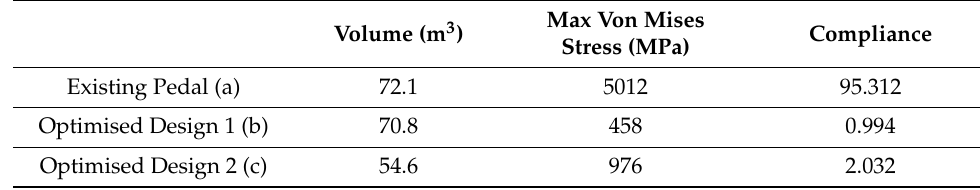
Figure 3. ( a ) Existing pedal ( b ) Optimised design 1 ( c ) Optimised design 2 Map showing the Von Mises distributions, reproduced from [60], with the permission from Inderscience, 2018. Table 10. Comparison of the three designs.